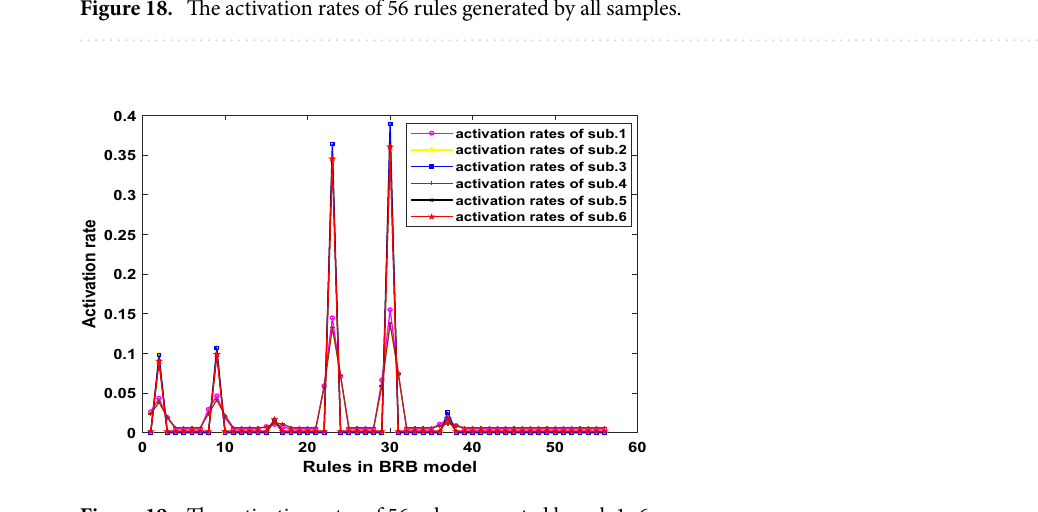
Figure 19. The activation rates of 56 rules generated by sub.1–6.